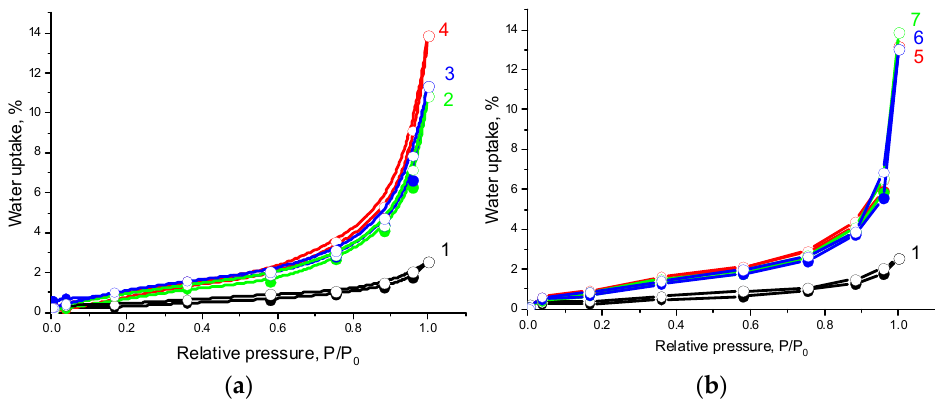
Figure 7. Water vapor adsorption (filled symbols) and desorption (open symbols) isotherms at 25 ◦ C on the samples: 1—PHBV/PCL(1:1), 2—PHBV/PCL(1:1)/CNC(PVP)–5, 3—PHBV/